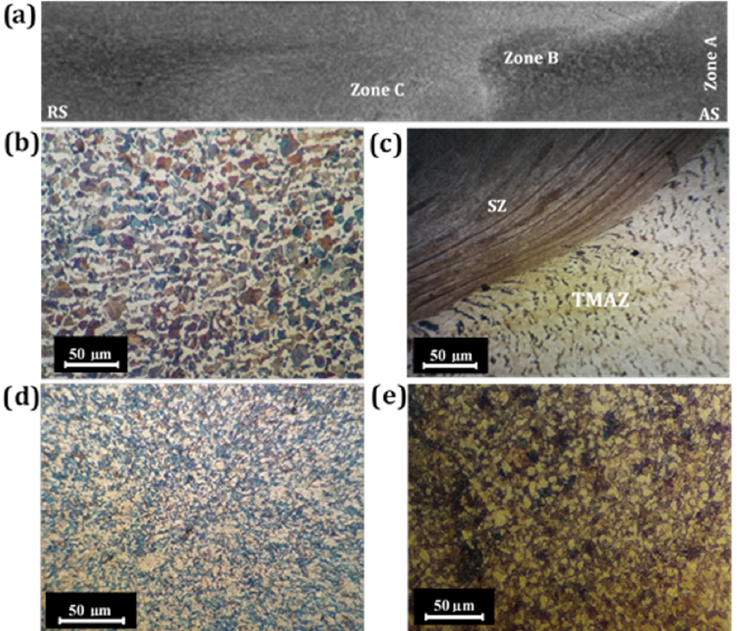
Figure 4. Macroscopic and microscopic evaluation of different zones in FSWed specimens (950 rpm, 24 mm/min): ( a ) macrograph depicting cross sectional plane perpendicular to FS weld direction; and microstructures of ( b ) base material, ( c ) stir zone/thermo-mechanically affected zone (SZ/TMAZ) border in FSW ( d ) Zone C in FSW and ( e ) CFSW.